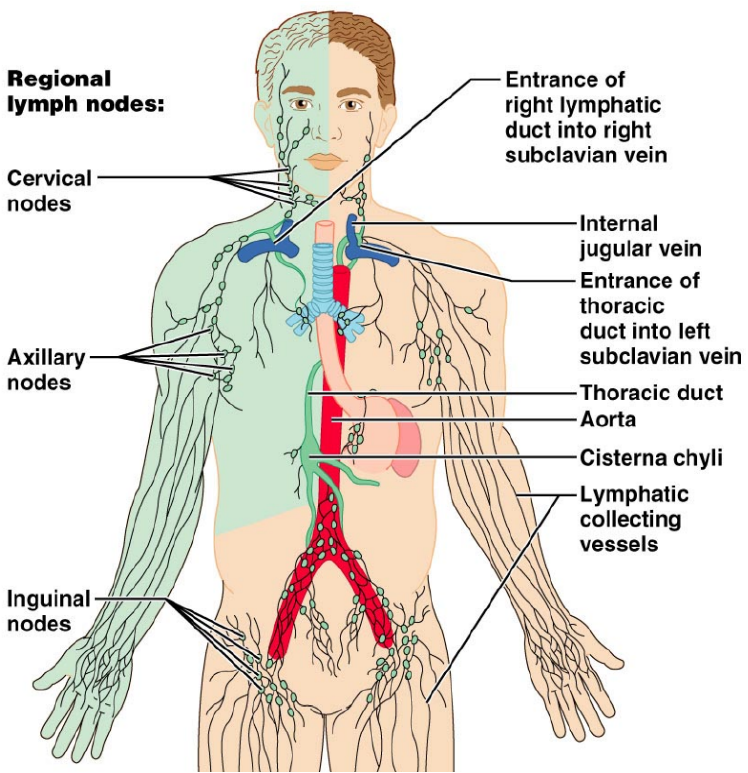
Figure 7. Diagrammatic illustration of the lymphatic drainage of the whole human body. The right upper extremity, right hemiface, and right hemithorax are drained by the right lymphatic duct (green-colored). The thoracic duct drains the rest of the human body.